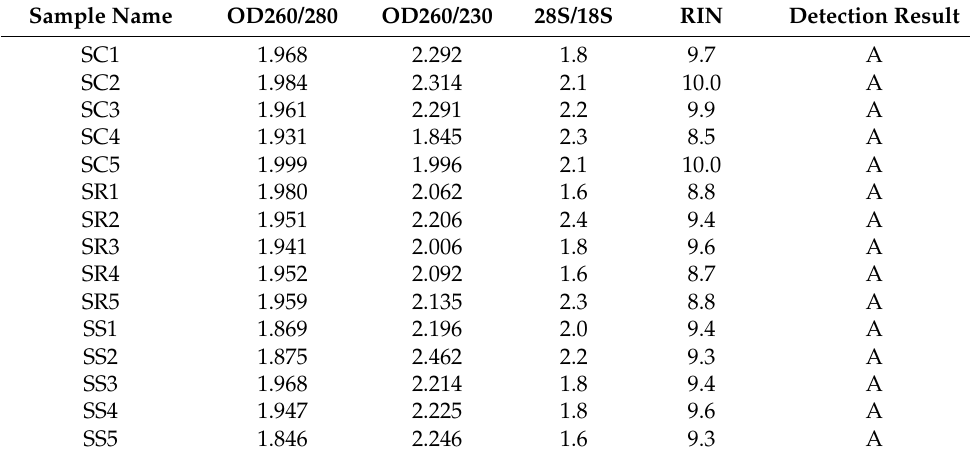
Figure 1. Agarose gel electrophoresis of total RNA of the spleen tissue. Table 3. The detection results of total RNA quality.